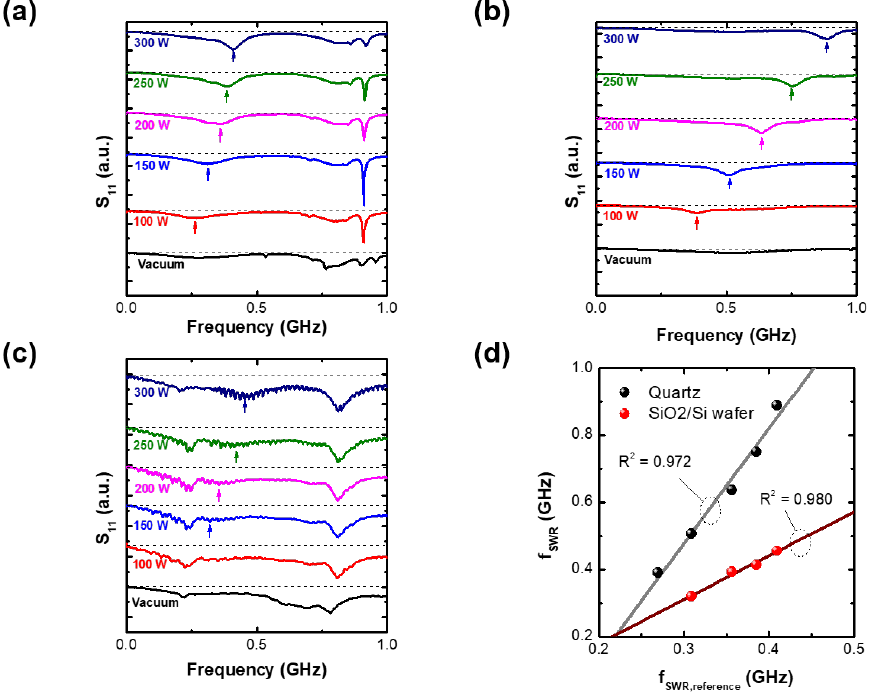
Figure 7. S 11 spectra with various RF powers at pressure of 100 mTorr at the RF2 in the cases of ( a ) reference, ( b ) quartz, and ( c ) SiO 2 (100 nm)/Si wafer, and ( d ) surface wave resonance frequencies ( f SWR s) for two cases over surface wave resonance frequency ( f SWR,reference ) for reference